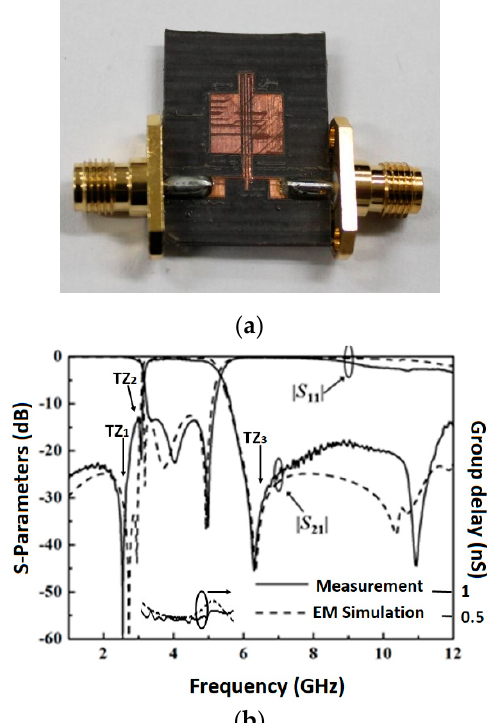
Figure 5. ( a ) Photograph and ( b ) simulated and measured results of the BPF with a wide stopband. L 1 = 3.35 mm, L 2 = 7.1 mm, L s = 13.7 mm, W 1 = 3.38mm, W 2 = 0.2 mm, W s = 0.2 mm, G 1 = 0.2 mm, G 2 = 0.15 mm, G 3 = 0.15 mm.